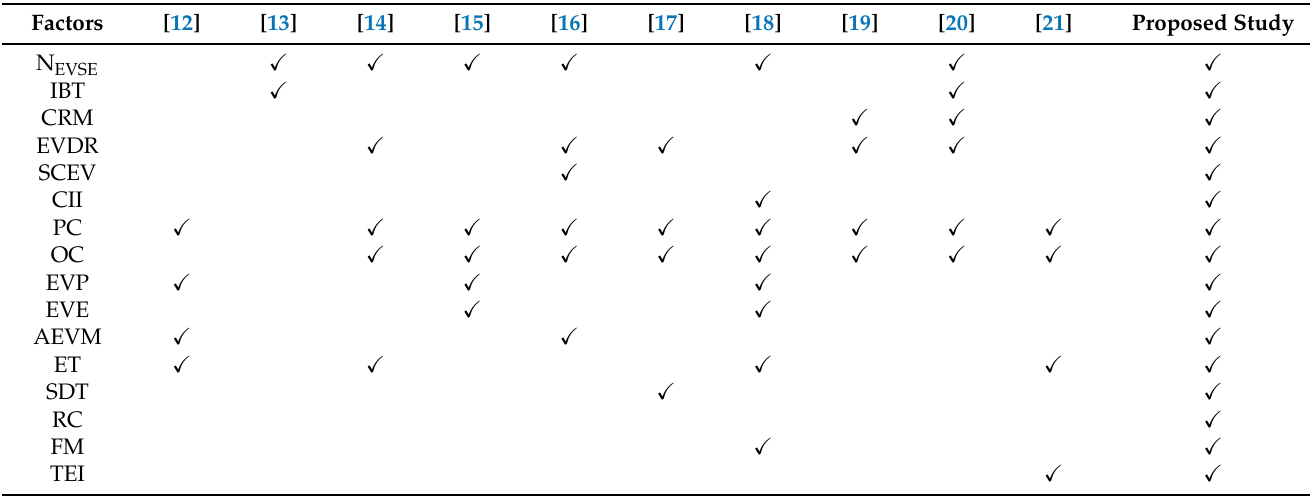
Table 1. Related work which identified or analyzed EV proliferation